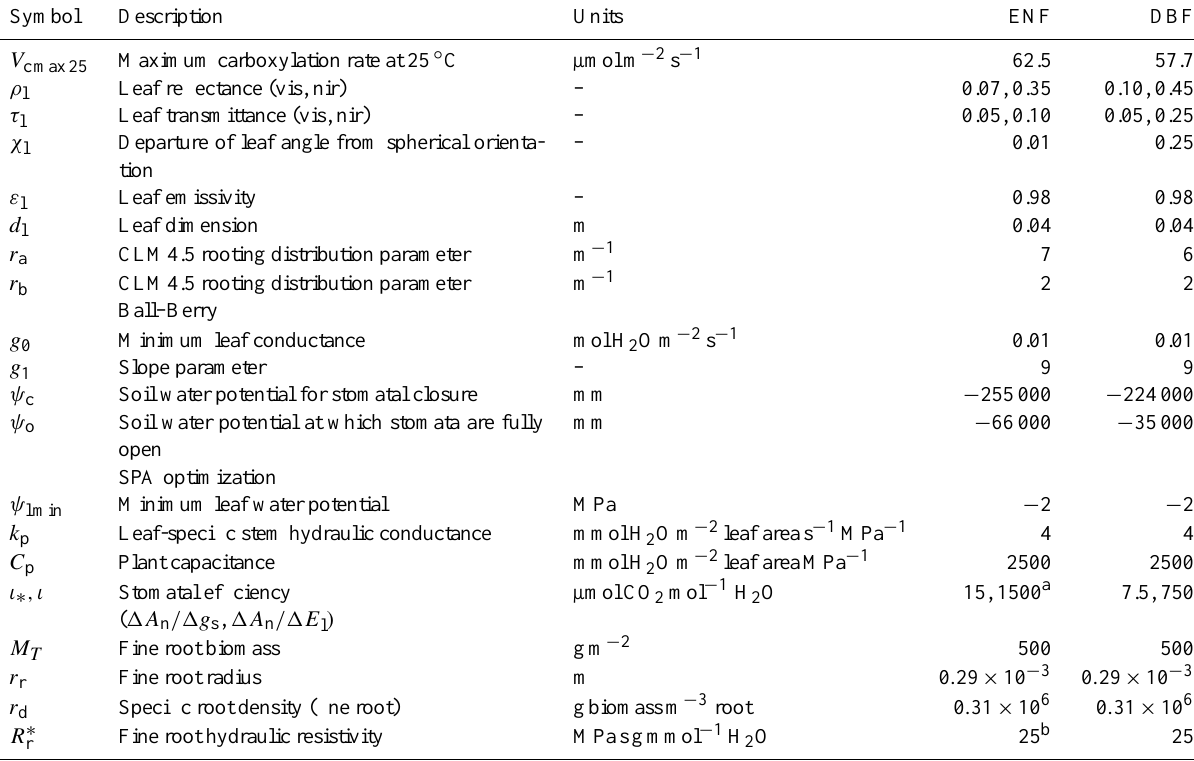
Table 3. Model parameter values for evergreen needleleaf forest (ENF) and deciduous broadleaf forest (DBF) plant functional types. Param- eter values are from CLM4.5 (Oleson et al., 2013), except for the stomatal optimization (as described in the text).